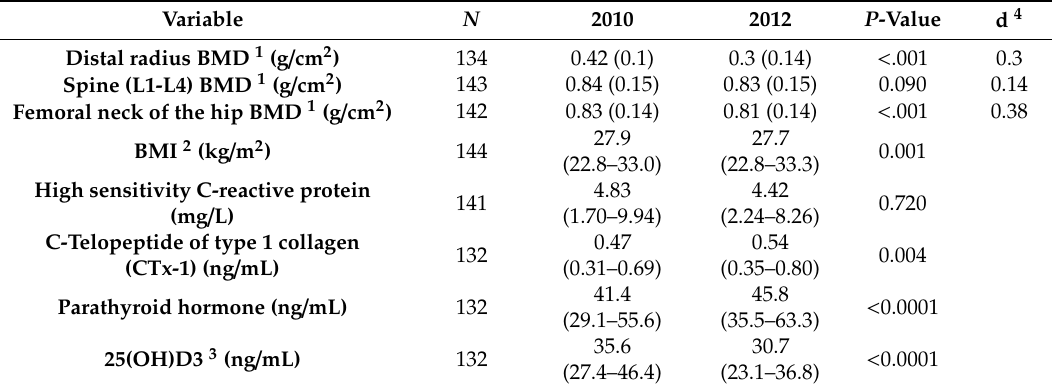
Table 3. The change in bone mineral density, body mass index, and bone turnover over two years.